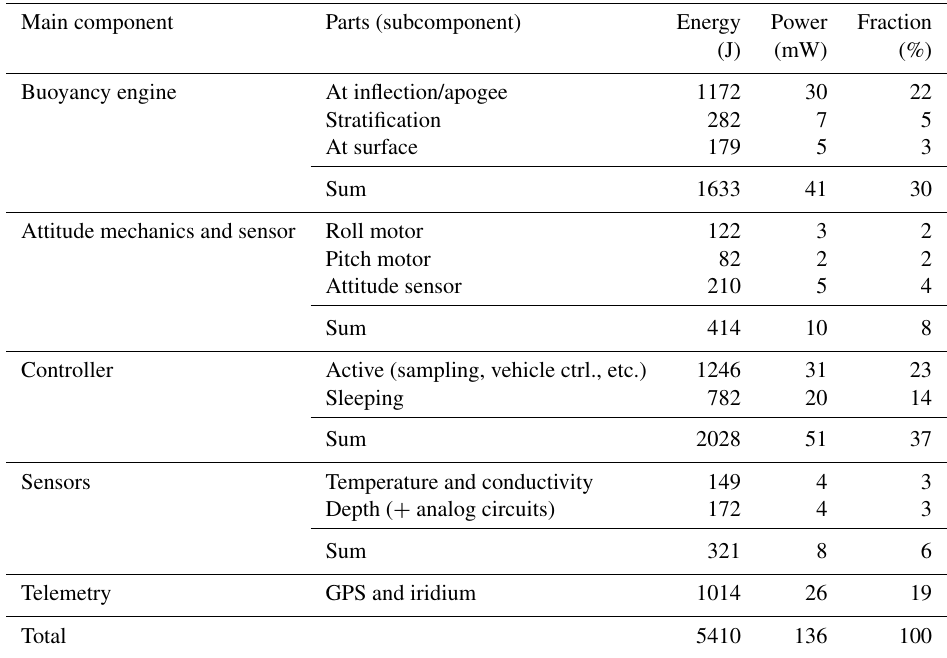
Table 1. Energy or power breakdown for low-power Seaglider dive to 1000m. Dive buoyancy was only ± 21cm 3 , and dive duration was 11h. In total 860 CTD samples were collected (non-uniform vertical sampling with 20s sampling rate in the upper 150m).